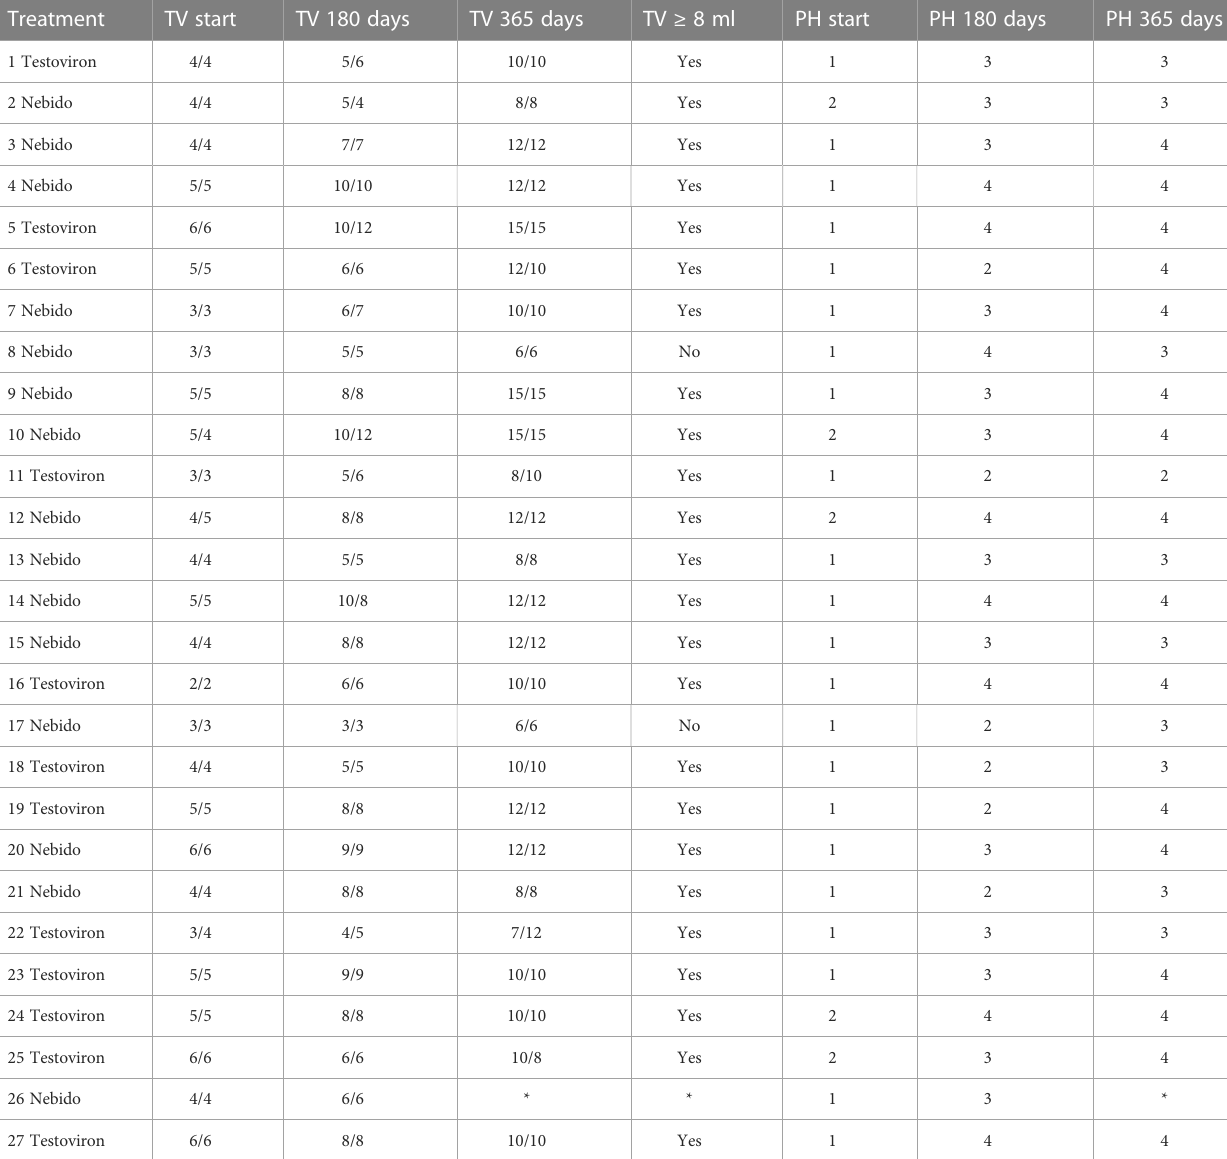
TABLE 2 Testicular volume (TV) and masculinization (PH) at the start and after 6 and 12 months in the Pubertal Replacement in Boys Study in patients treated with Nebido ® or Testoviron Depot ® .